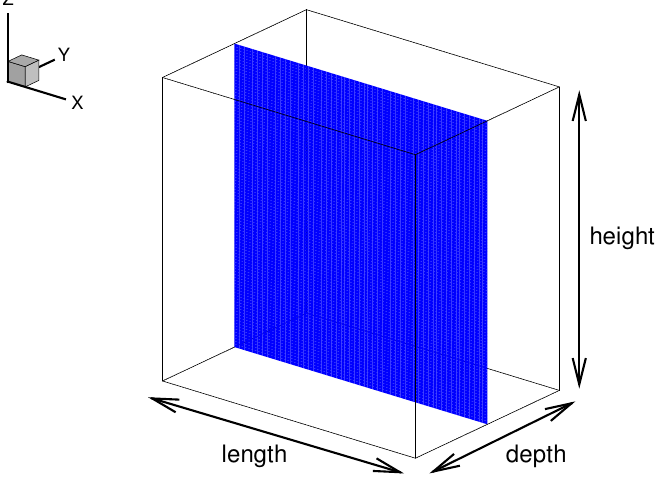
Figure 2. Simulation geometry. The blue plane illustrates the “ x - z middle plane” described in the text. Grid independence tests in a typical shear test showed a variation in the deformation parameter up to 4.5 % for a droplet with radius R = 10 lattice units ( l . u .), and below 1% for a droplet of 30 l . u